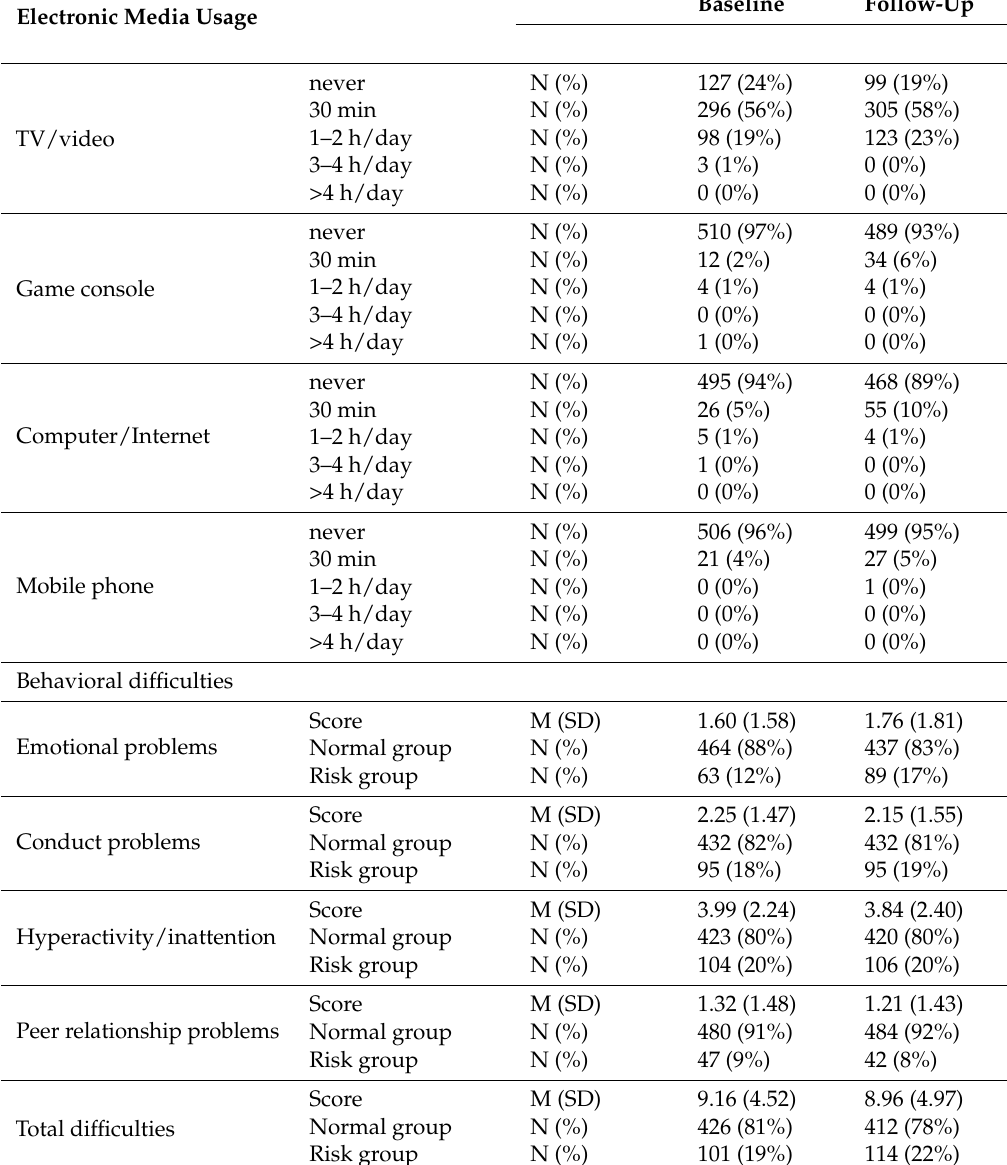
Table 1. Electronic media consumption and behavioral difficulties in the present sample (N =